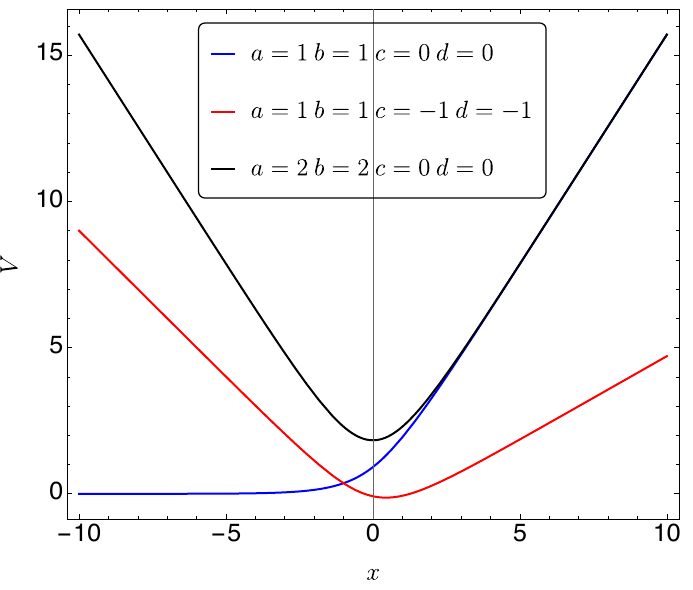
Figure 2 . Examples of extremal